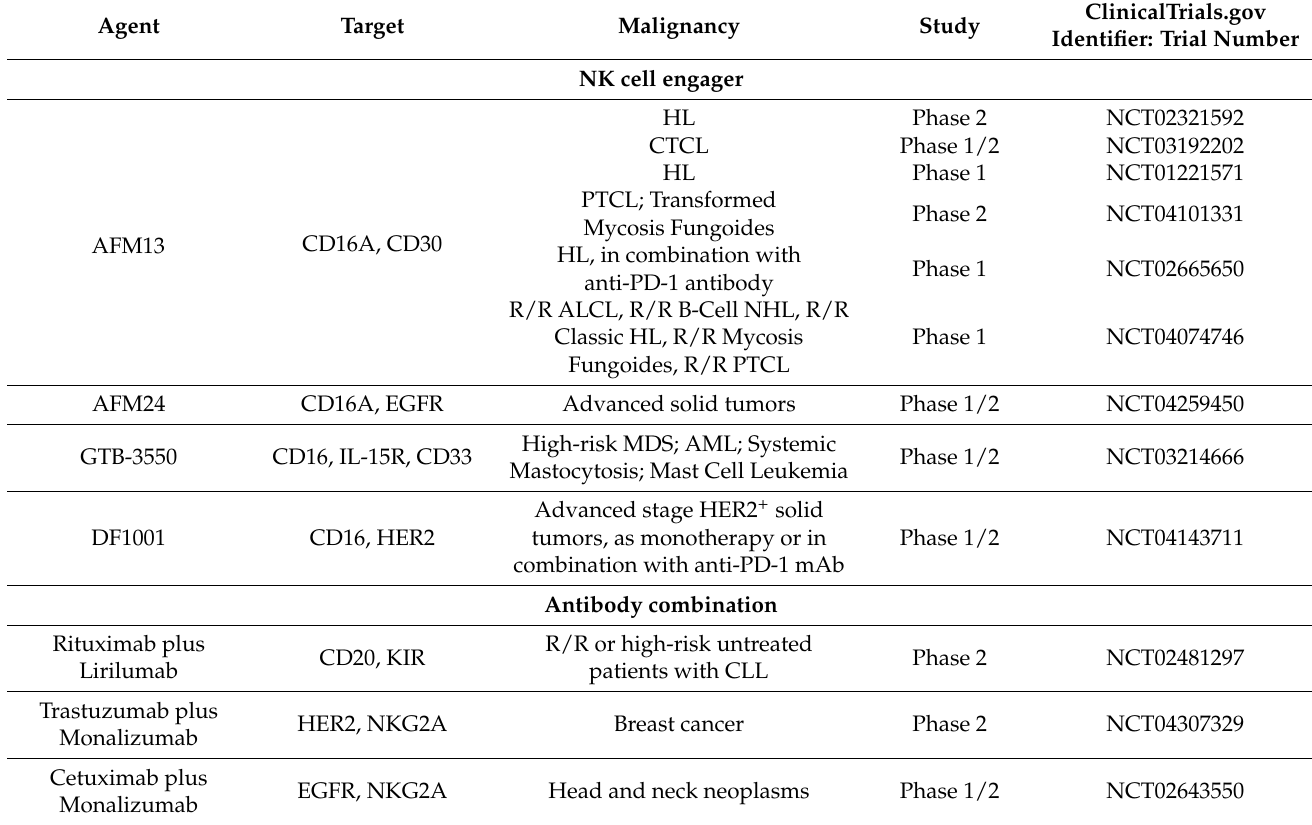
Table 1. Selected ongoing clinical trials aimed at potentiating endogenous NK cell response to tumor-targeting mAbs. Agent Target Malignancy Study